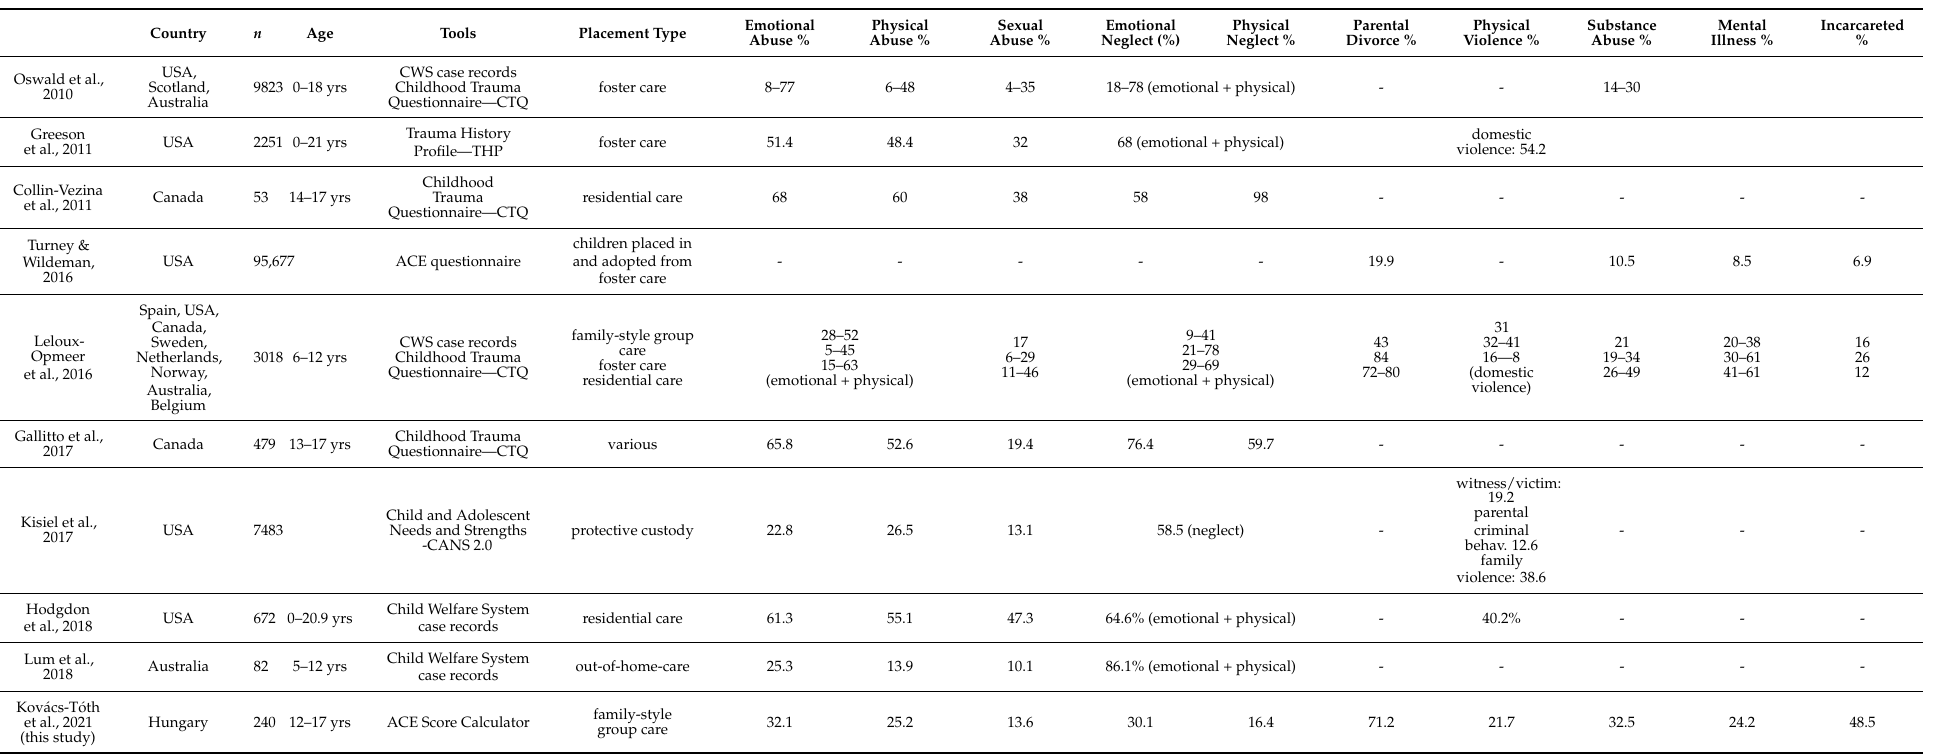
Table A2. Maltreatment and family dysfunction rates found in some studies in the Child Welfare